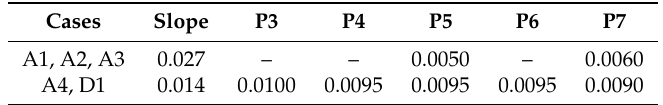
Table 3. Sensor head adjustment, δ e , between the model and experimental sensors for different bed slopes. Values for P3—P7 are in meters of